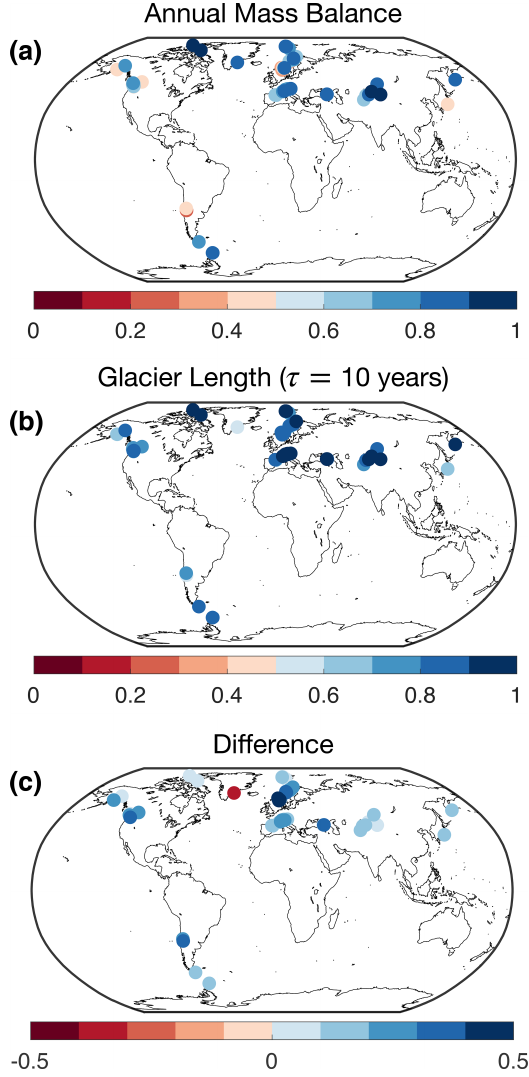
Figure 6. The importance of summertime temperature in driv- ing overall variance in mass balance and glacier length across the glacier network, calculated for the pre-industrial era (1000 to 1880). Panel (a) shows the fraction of total variance in mass balance that is due to summer temperature. Panel (b) shows the same thing, but for glacier length. The difference is shown in panel (c) , from which we see that, in all but one case (Mittivakkat in Greenland), summer tem- perature accounts for a larger fraction of variance in glacier length than in annual mass balance. This is due to the low-pass-filtering properties of glacier